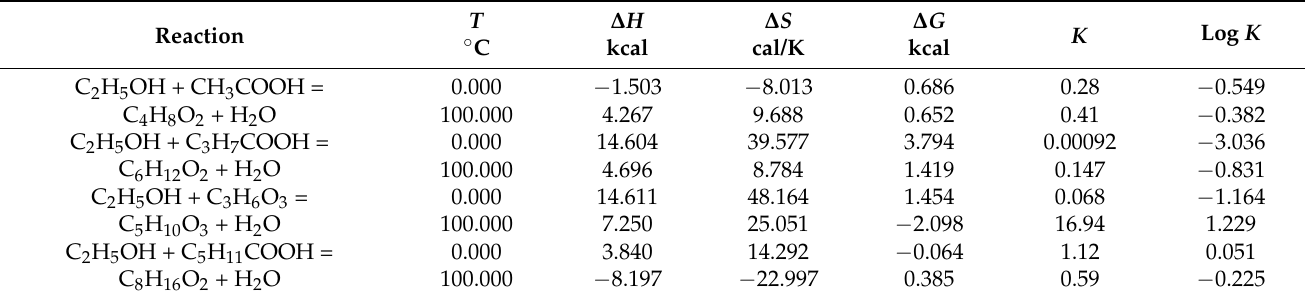
Table 1. Thermodynamic data of esterification reactions (ethyl acetate, ethyl hexanoate, ethyl lac- tate, and ethyl butyrate) in Baijiu, calculated by HSC Chemistry (version of 9.30) using the Reaction Equations module.